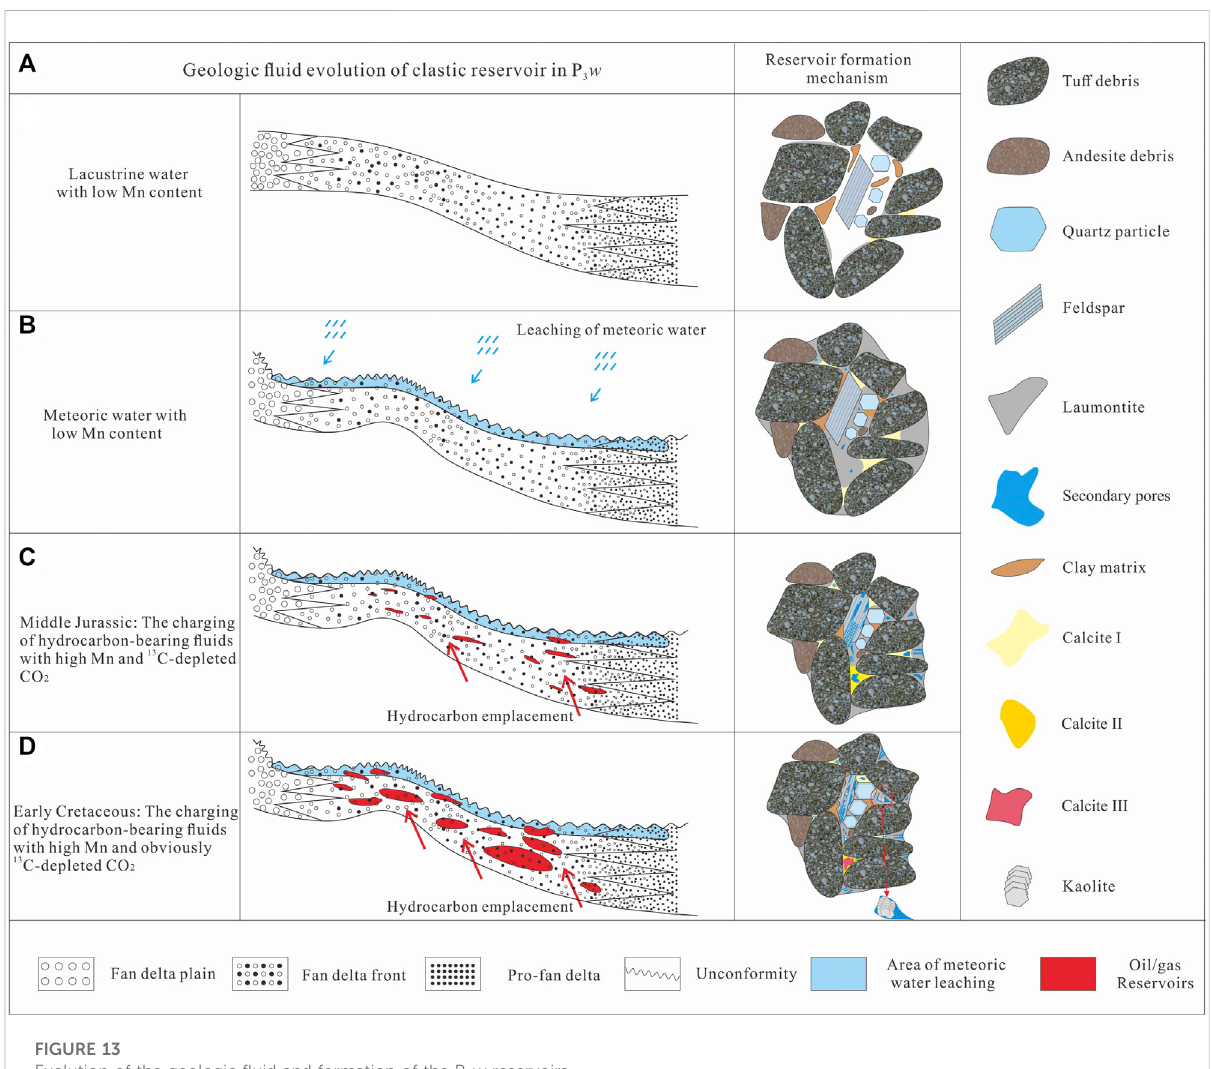
FIGURE 13 Evolution of the geologic fl uid and formation of the P 3 w